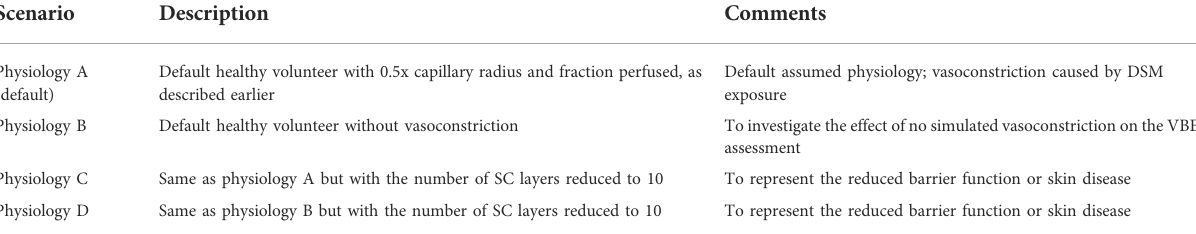
TABLE 3 Description of physiological parameters tested in the virtual bioequivalence